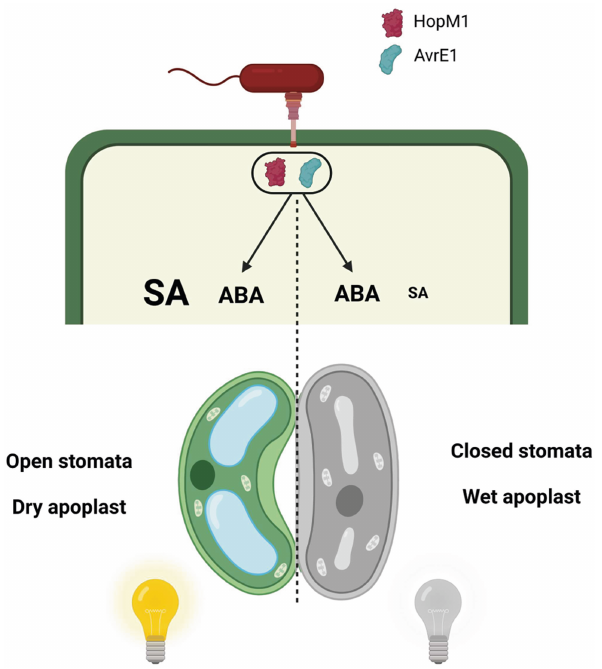
Fig. 7 | Model for light-induced disease resistance in plants. In continuous light (left), HopM1 and AvrE1-mediated stimulation of ABA biosynthesis and signaling occurs.However,elevatedSAaccumulationincontinuouslightconditionsensures that stomata remain open despite the pro-closure in fl uence of ABA, thus prevent- ing water-soaking. When plants experience a period of darkness (right), the pro- closurein fl uenceof ABA predominates, possibly due to reduced SAaccumulation, leading to water-soaking. This fi gure was created with